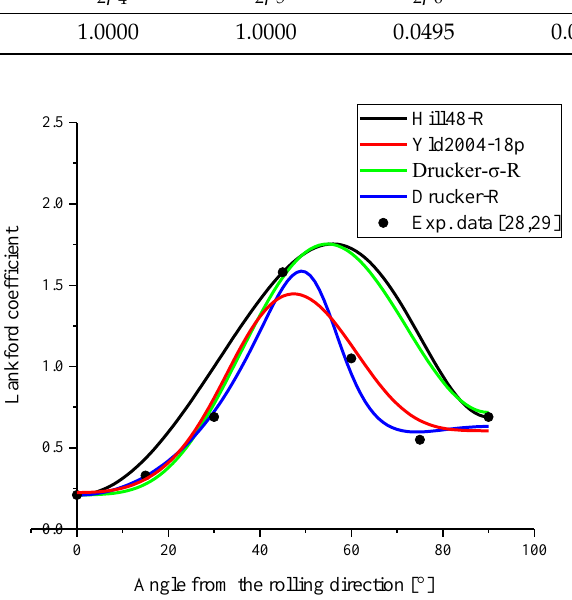
Figure 7. The R-value directionality with four yield functions for AA 2090-T3 sheet.